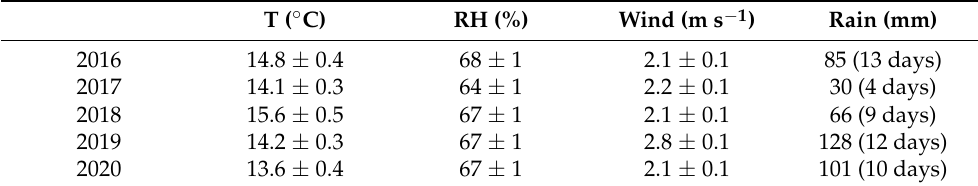
Table 1. Mean average meteorological variables for the lockdown period in 2020 and the same days in